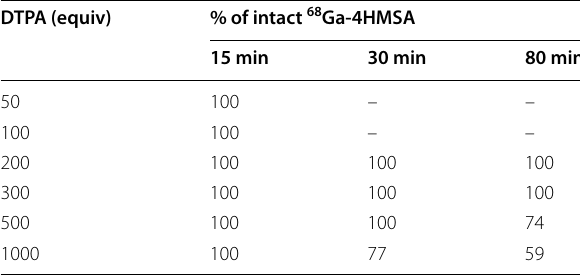
Table 2 Transchelation of [ 68 Ga]Ga‑4HMSA with